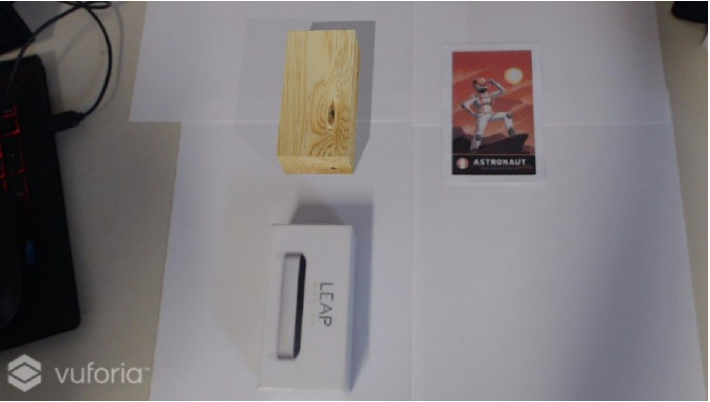
Figure 21. Comparison between Real and Virtual Shadows.